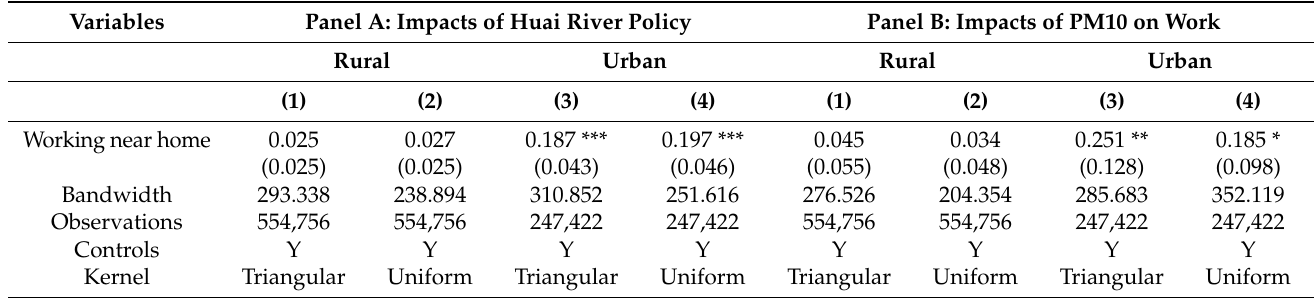
Table 6. The impacts of PM 10 on work by rural–urban.